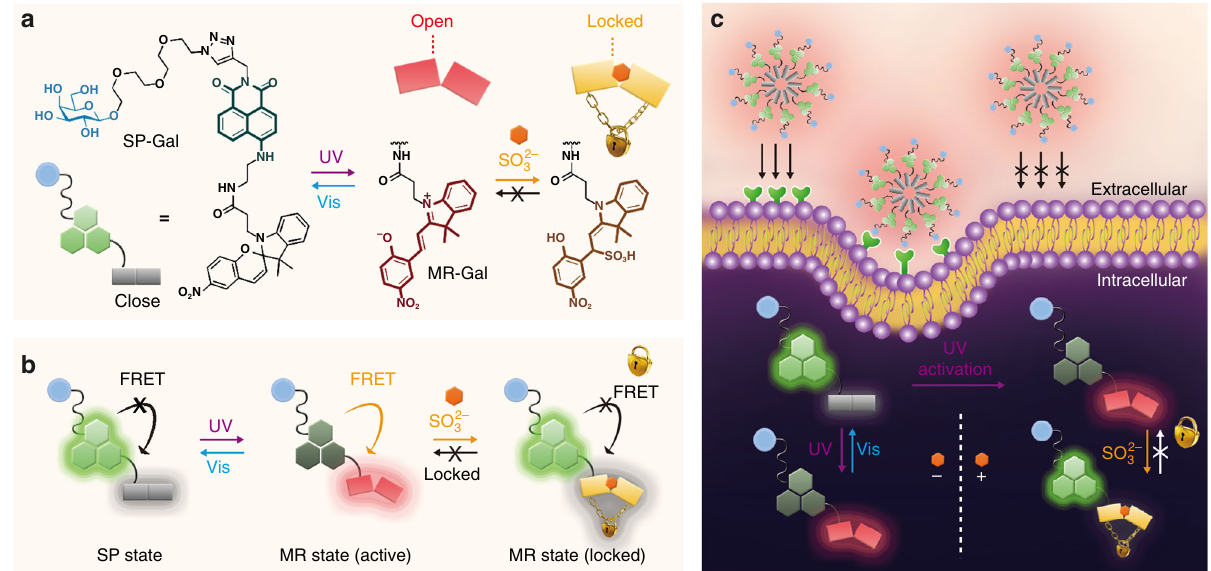
Fig. 1 Molecular design of the photochromic fl uorescent SP-Gal and its working mechanism in solution and intracellularly. a Structure and photochromism/ sul fi te (SO 3 2 − ) reactivity of SP-Gal. b Schematic illustration of the fl uorescence “ off-on ” switching (FRET = Förster Resonance Energy Transfer) and sul fi te- induced fl uorescence locking of SP-Gal. c Schematic illustration of receptor-targeting intracellular photochromism of glycoprobe and their target (sul fi te) recognition controlled by remote